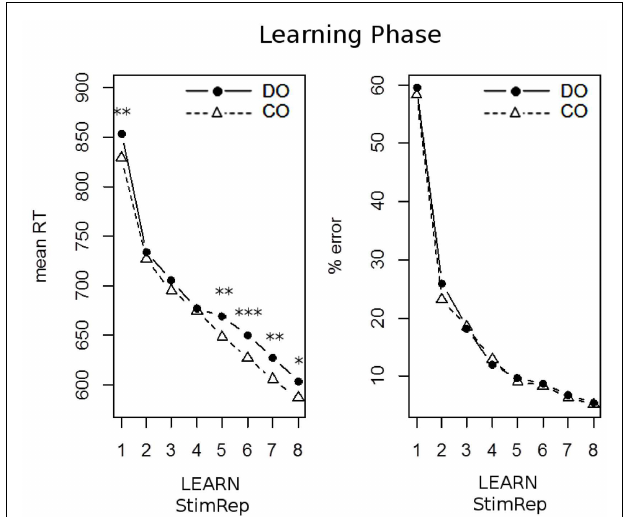
FIGURE 2 | Performance across the initial learning phase of Exp. 1 for mean response times (left panel) and mean% errors (right panel). DO denotes the Differential Outcome condition, CO denotes the Common Outcome condition. Learning is expressed in terms of correctly implemented stimulus repetitions (StimRep). Asterisks denote significant differences between DO and CO (* p < 0.05; ** p < 0.01; *** p < 0.001).